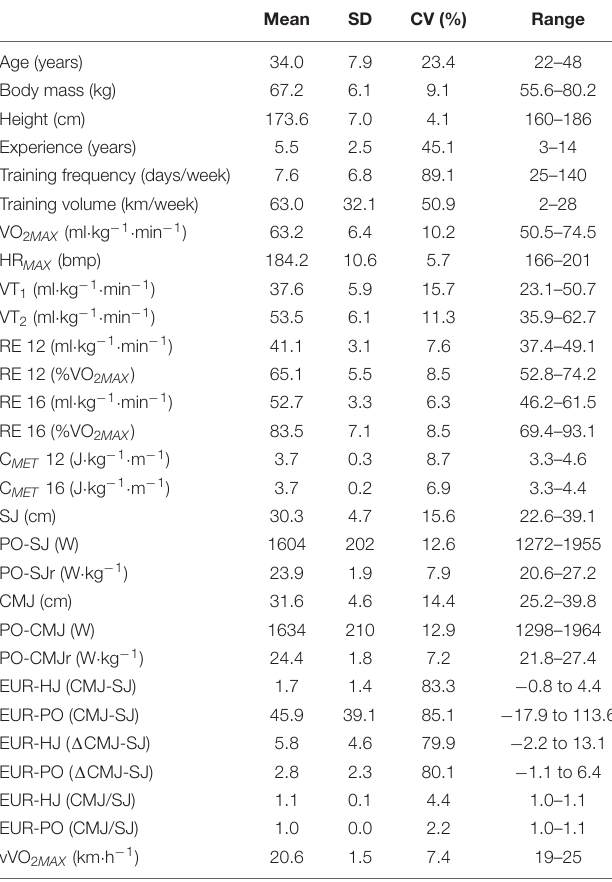
TABLE 1 | Descriptive values of all variables evaluated of runners.